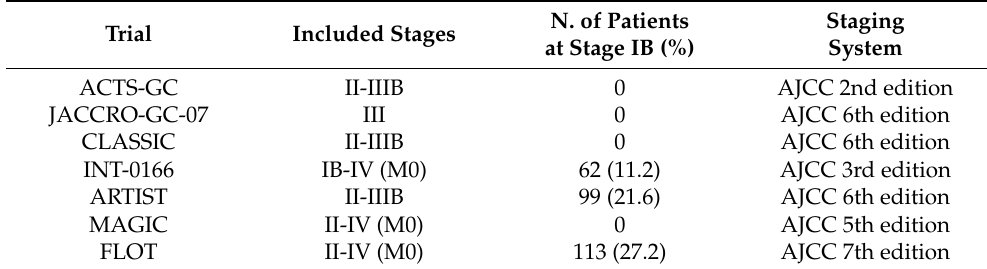
Table 2. Number of patients at stage IB enrolled in clinical